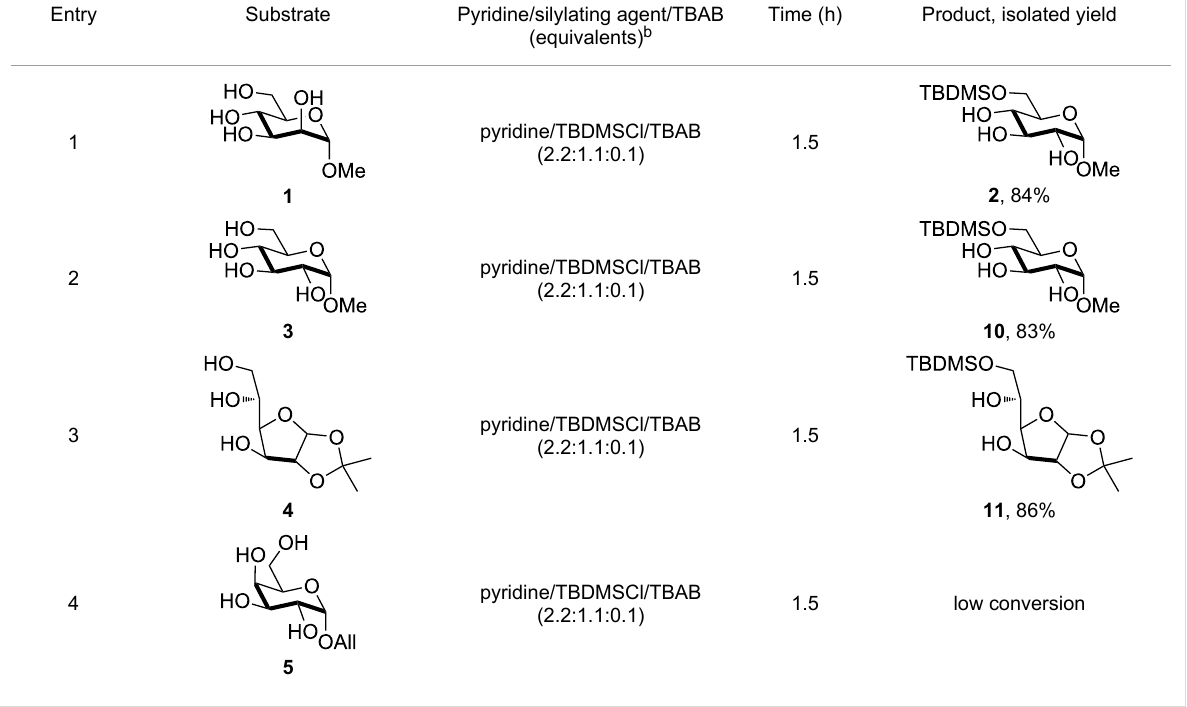
Time (h) Product, isolated (equivalents) b